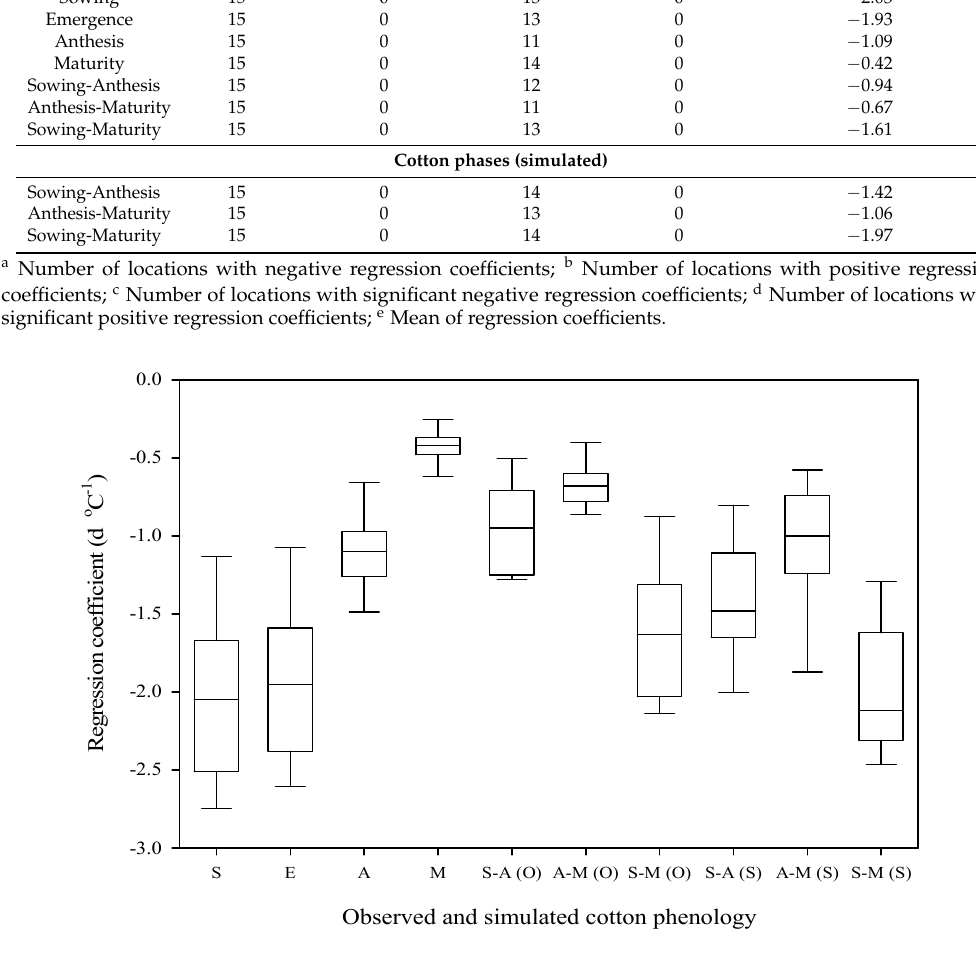
Figure 7. Observed phenology (stages and phases) and simulated phenology (phases) versus temperature trends of cotton, based on data from 15 locations in Punjab, Pakistan, from 1980 to 2015. S: sowing; E: emergence; A: anthesis; M: maturity; S-A: sowing − anthesis; A-M: anthesis − maturity; S − M: sowing − maturity; (O): observed; (S) simulated. Central horizontal line: median; box limits: 25th and 75th percentiles; whiskers: minimum and maximum values.